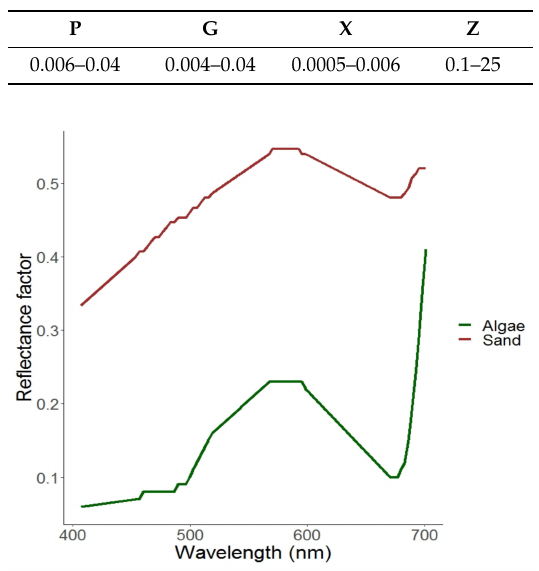
Table 3. Parameter ranges used for forward modeling.